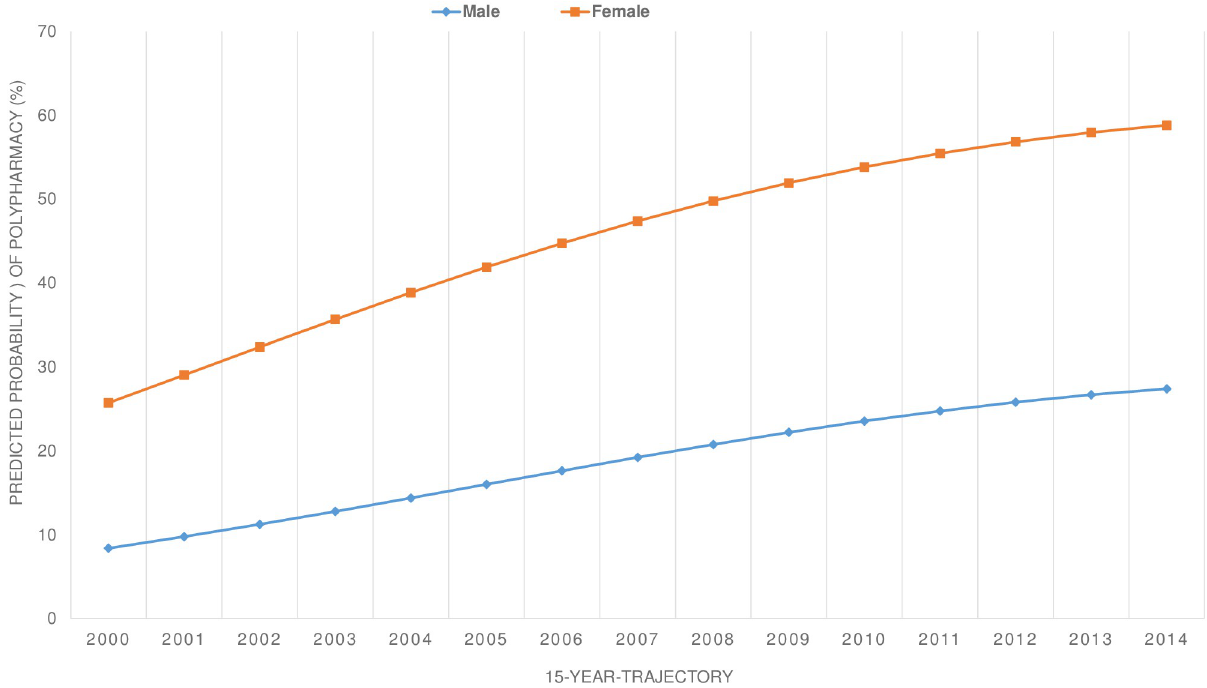
Fig 4. Predicted cumulative proportion of polypharmacy over the 15-year trajectory stratified by sex.